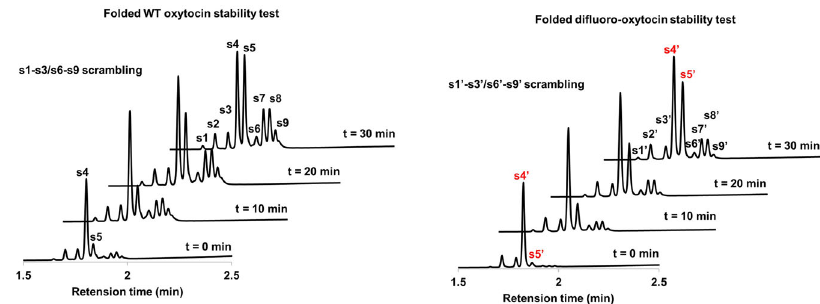
Fig. 9 Folded di fl uoro-oxytocin stable than folded WT oxytocin. s4: fold WT-oxytocin, s5: linear WT oxytocin; s4 ′ : fold di fl uoro-oxytocin, s5 ′ : linear di fl uoro-oxytocin, s1 – s3/s6 – s9 scrambling, s1 ′ – s3 ′ /s6 ′ – s9 ′